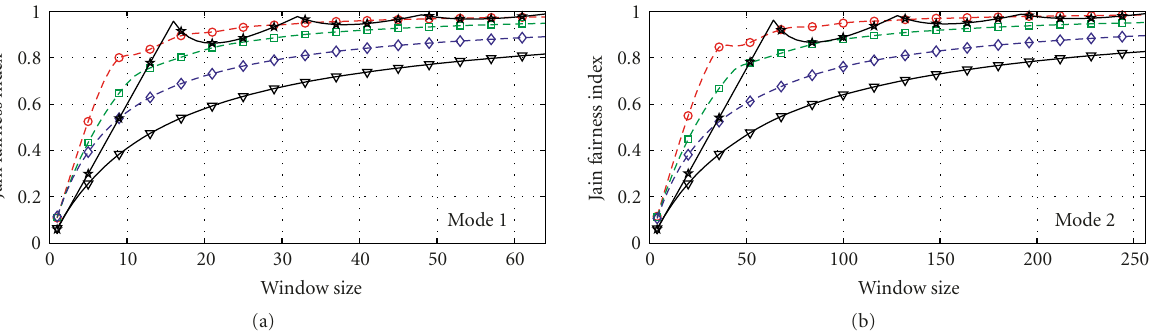
Figure 7: Virtual MIMO system throughput fairness index for two-antenna mode 1 ( K = 16) and mode 2 ( K = 64) in the presence of Rayleigh fading, constant Tx power ( P = 15 dB), and SIR CQI. Solid curves with stars (“ (cid:3) ”) refer to TDMA-RR, while solid lines with triangles (“ (cid:5) ”) correspond to TDMA-BUS. Dashed curves with circles (“ ◦ ”), dashed curves with squares (“ (cid:6) ”) and dashed curves with diamonds (“ (cid:14) ”) refer to pure ORR (ZFBF-PF fairness upper bound), ORR-SIR and ZFBF-SUS (ZFBF-PF fairness lower bound), respectively.